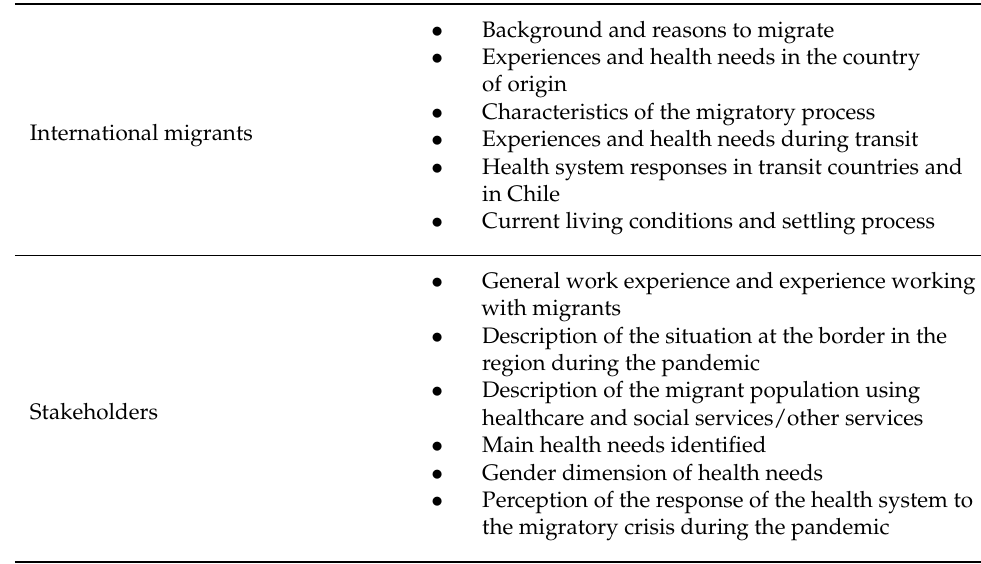
Table 1. Summary of interview